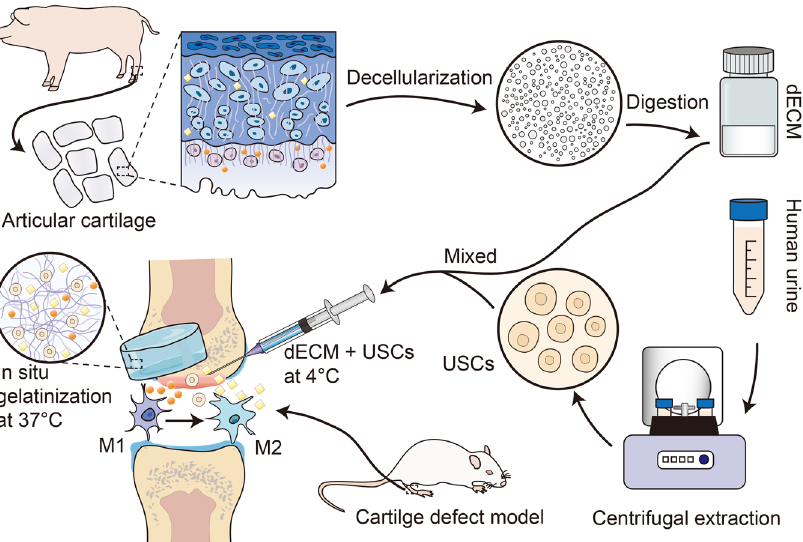
Fig. 1 Graphical abstract of the study. Schematic illustrations of the injectable decellularized cartilage matrix (dECM) hydrogel encapsulating human urine-derived stem cells (USCs) for immunomodulatory and cartilage defect